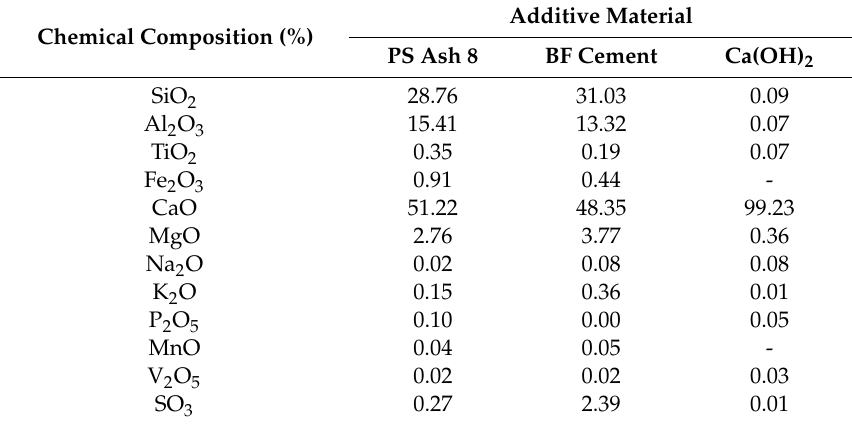
Table 2. Chemical composition of additive materials.